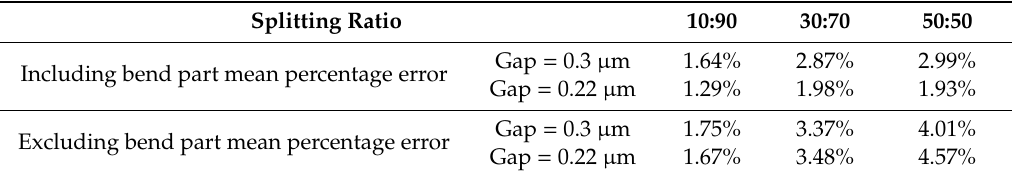
Table 3. Mean percentage error of MZDC including/excluding bend effects.